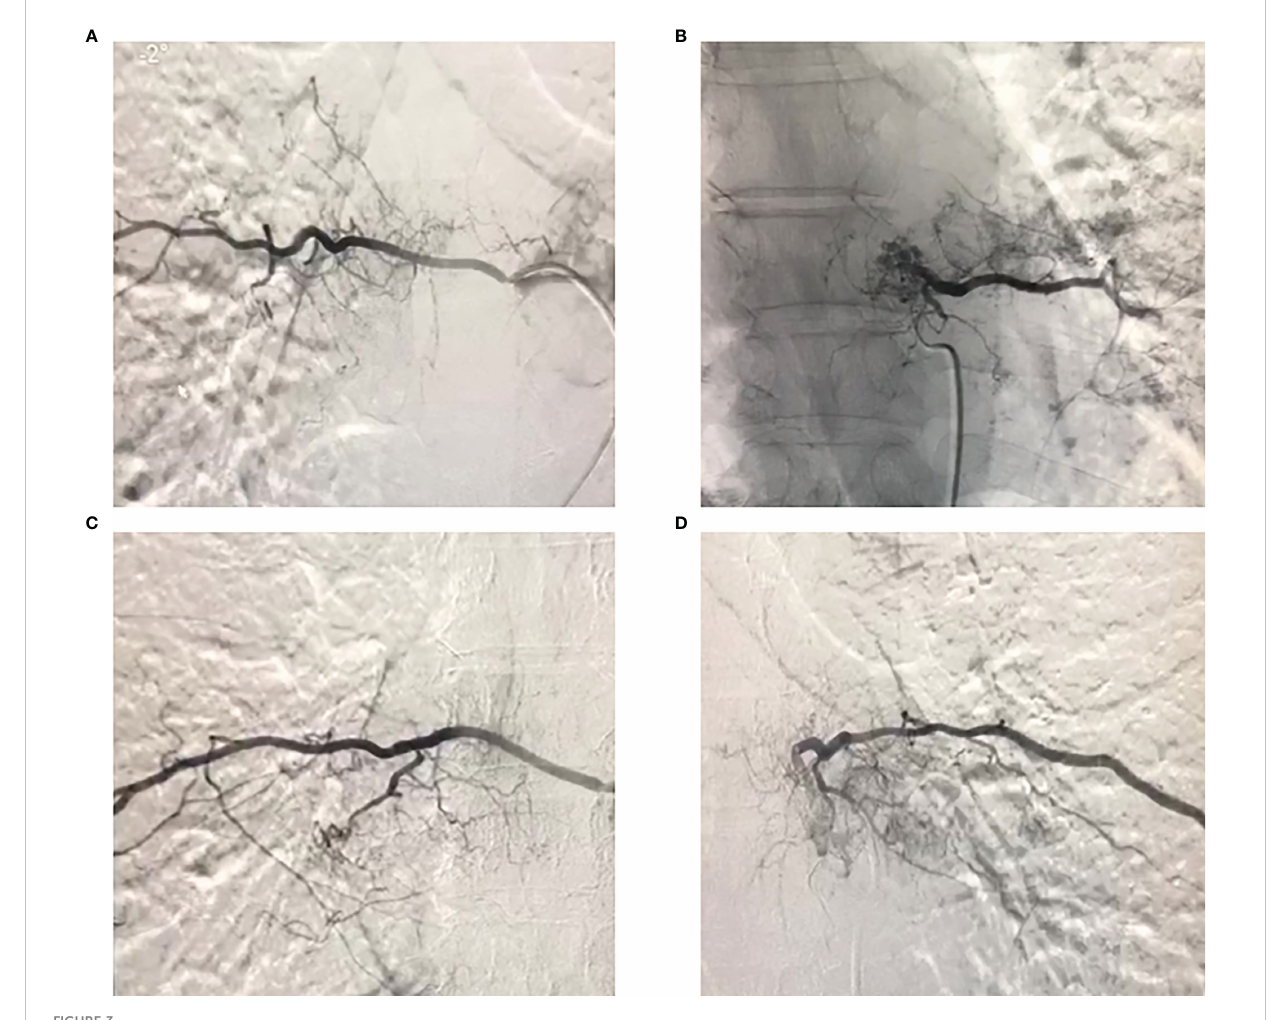
FIGURE 3 Preoperative angiography of the 7th and 8th thoracic vertebral segment arteries showed that the tumor had a rich blood supply, and embolization was